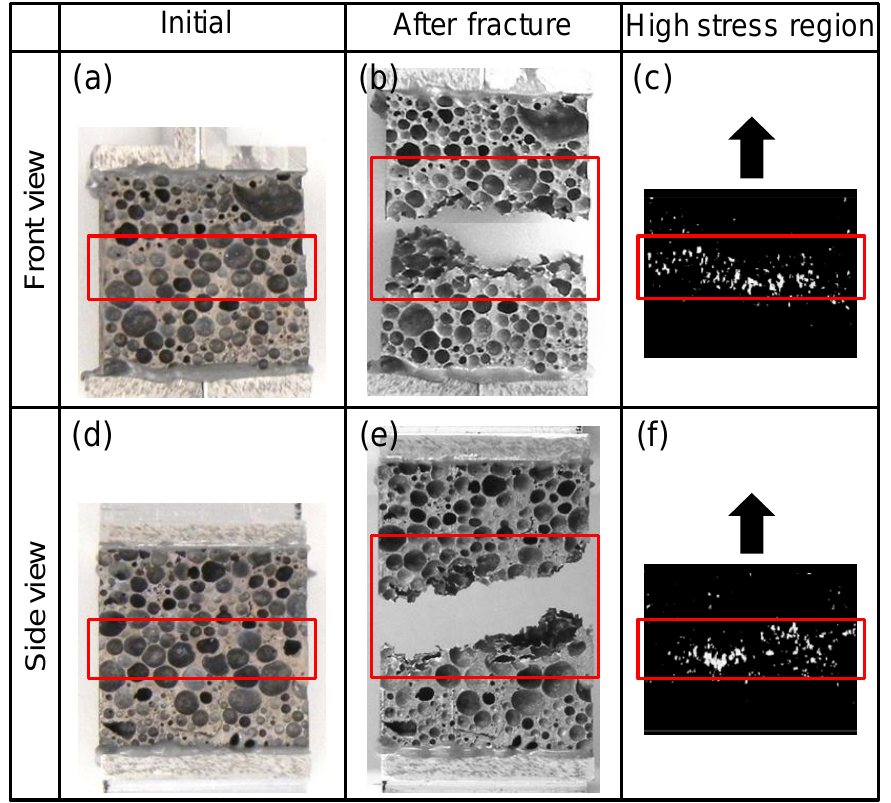
Figure 6. Tensile test behavior and corresponding FE analysis of ADC12 foam ( p = 70.3%) showing front and side views: ( a ) and ( d ) initial pore structure; ( b ) and ( e ) pore structure after fracture; and ( c ); and ( f ) Mises equivalent stress distributions obtained by image-based FE